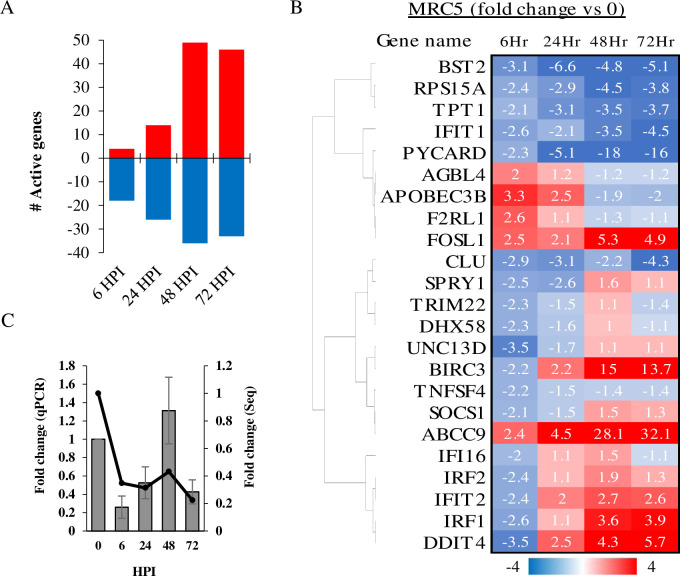
Expression of genes involved in antiviral response following HCoV-229E infection.(A) Sum of up and downregulated genes in MRC-5 cells at each time point post HCoV-229E infection are presented in red and blue, respectively. (B) Early activated antiviral response genes. Genes that were >2 or <-2 fold change in MRC-5 cells at 6 hours post HCoV-229E infection are presented in fold change heat map in following HPI. (C) Validation of gene expression. Cells were infected with HCoV-229E and total RNA was extracted and treated as described in the Methods section. Relative gene expression was calculated for CLU mRNA. Fold-change in transcripts levels, as measured by qPCR analysis (Bars, left Y axis), was compared to the results of the NGS analysis (line, right Y axis).